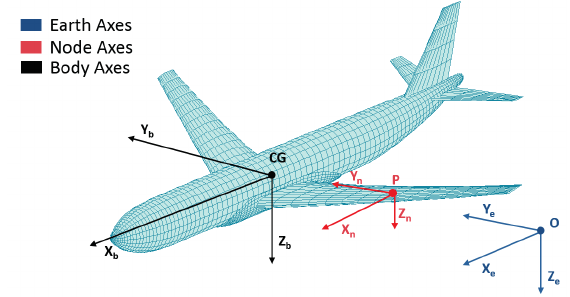
Figure 5. The forebody of the fuselage is modelled as an axisymmetric slender body (ESDU 89008 and ESDU 89014) and the aftbody is modelled as an axisymmetric conical body (ESDU 87033).